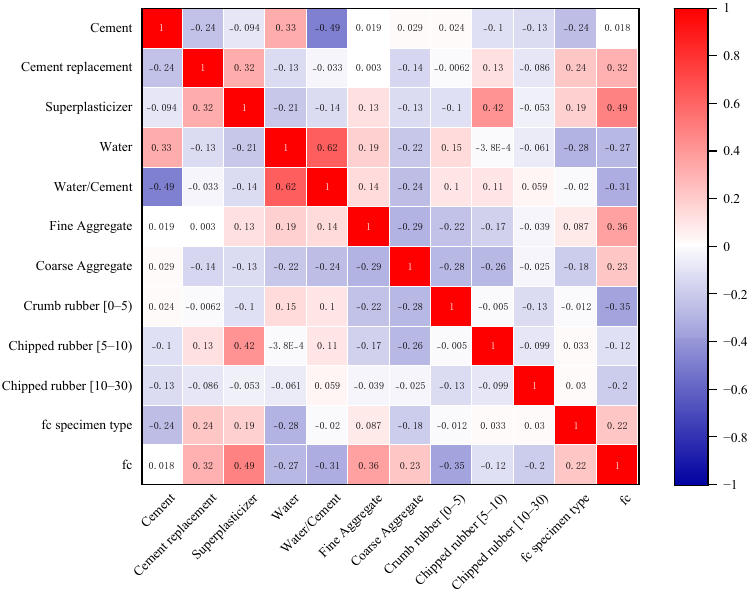
Figure 1. Heat map of the correlation for each variable. Table 2. Parameter setting of ANN model.